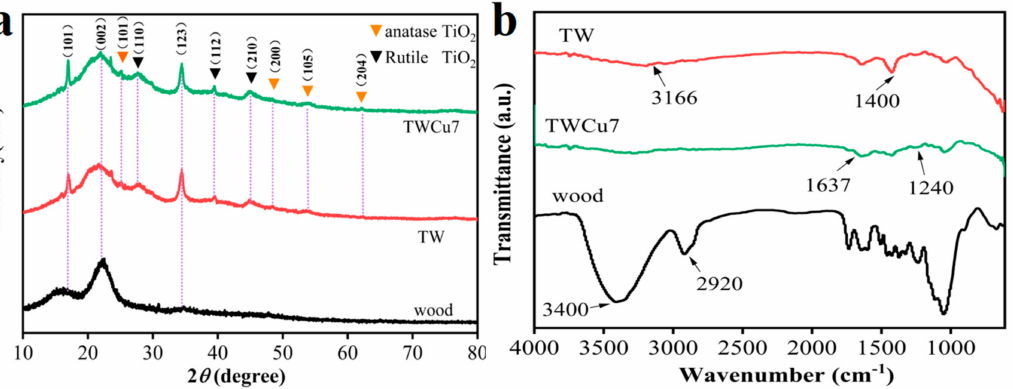
Figure 2. ( a ) XRD patterns of wood, TW, and TWCu7 samples. ( b ) FTIR spectra of wood, TW, and TWCu7